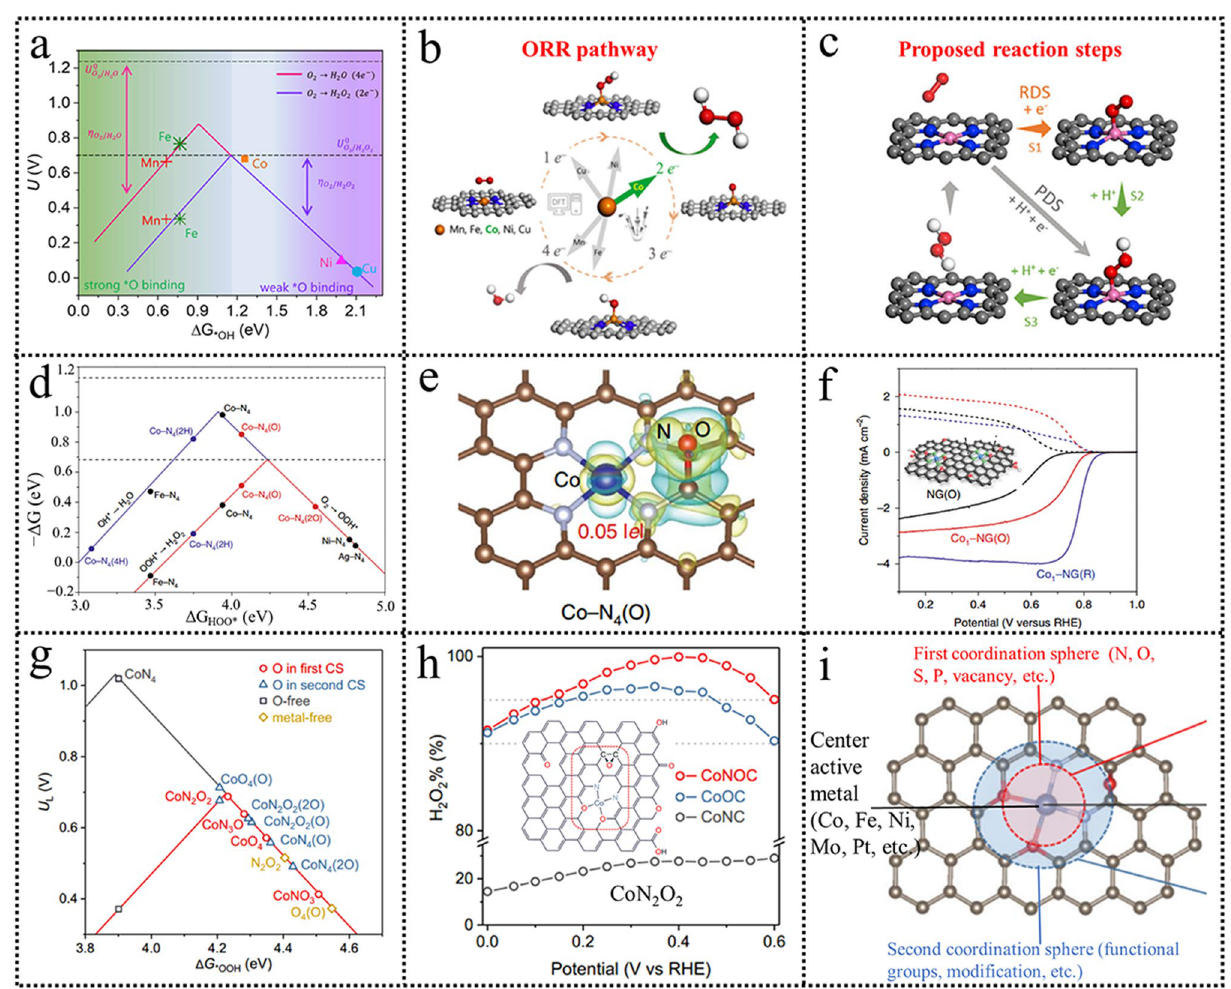
Fig. 10 a Activity-volcano curves of ORR on M–N–C. b Schematic of the ORR pathway on M–N–C. c Proposed reaction steps of H 2 O 2 syn- thesis over Co-NC. Reproduced with permission [119]. Copyright 2020, Elsevier. d Calculated catalytic activity volcanoes for the production of H 2 O (blue) and H 2 O 2 (red) via the ORR (bottom panel). e Differential charge densities of Co–N 4 (O). f Comparison of ORR performance for NG(O), Co 1 –NG(O) and Co 1 –NG(R) catalysts. Reproduced with permission [120]. Copyright 2020, Springer Nature. g Computed activity vol- cano plots of ORR via the 2e − (red color) or 4e − (black) pathway for SACs with varied configurations. h Calculated H 2 O 2 selectivity (H 2 O 2 %). i Schematic of SACs, highlighting the first and second coordination spheres and center active metal. Reproduced with permission [114]. Copy- right 2021, American Chemical Society. (Color figure